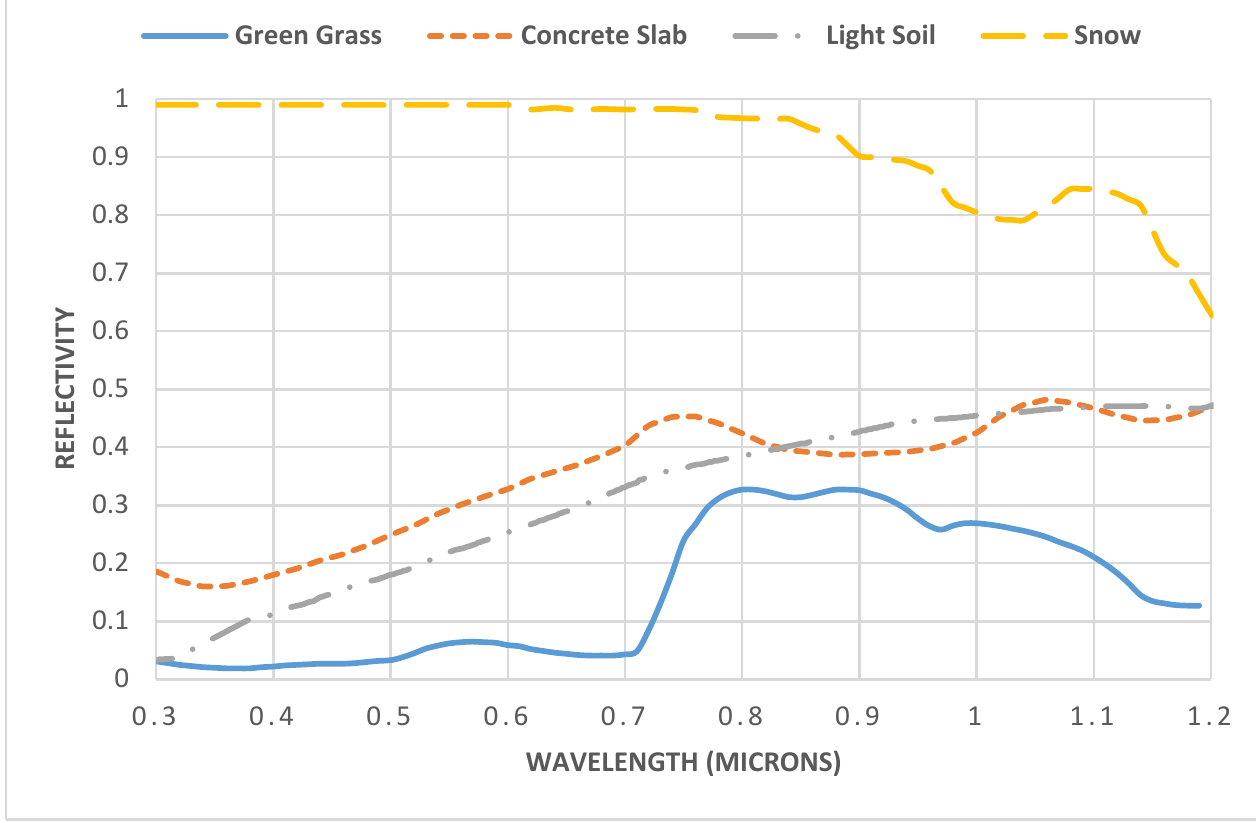
Figure 5. Spectral reflectance of four ground surfaces from SMARTS in the C-Si spectral range [38].